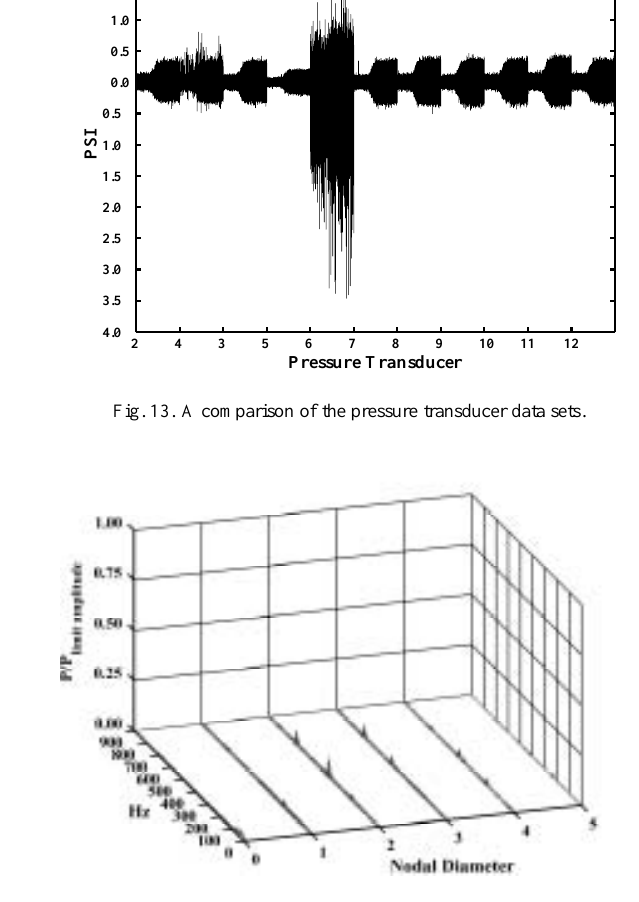
Fig. 14. Two-dimensional Fourier transform of pressure transducer data at 9